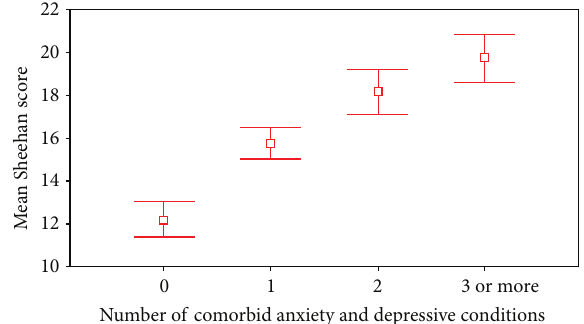
Figure 1: Number of comorbid conditions by mean total Sheehan